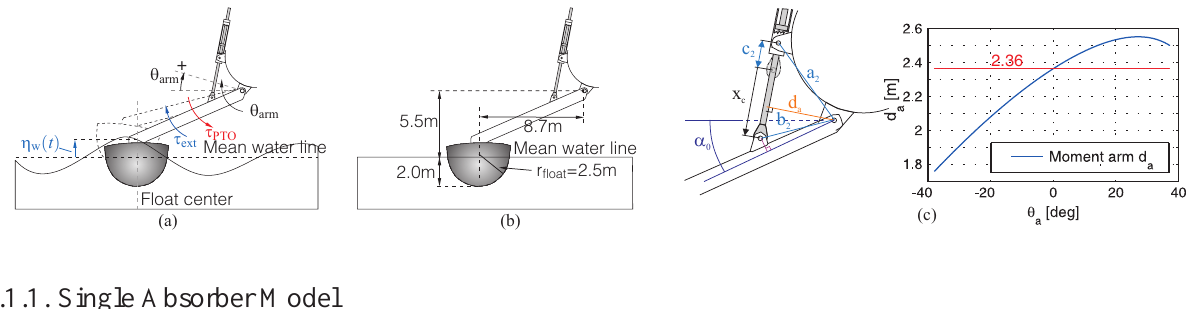
Figure 10. ( a ) definition of variables of the Wavestar absorber; ( b ) some dimensions for the case study; and ( c ) the moment arm of the